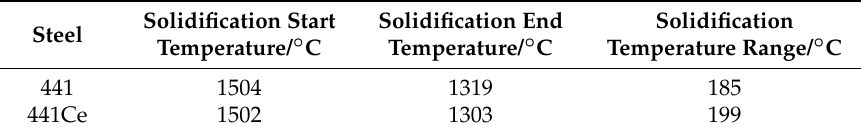
Table 2. The solidification temperature range obtained by simulation calculation.